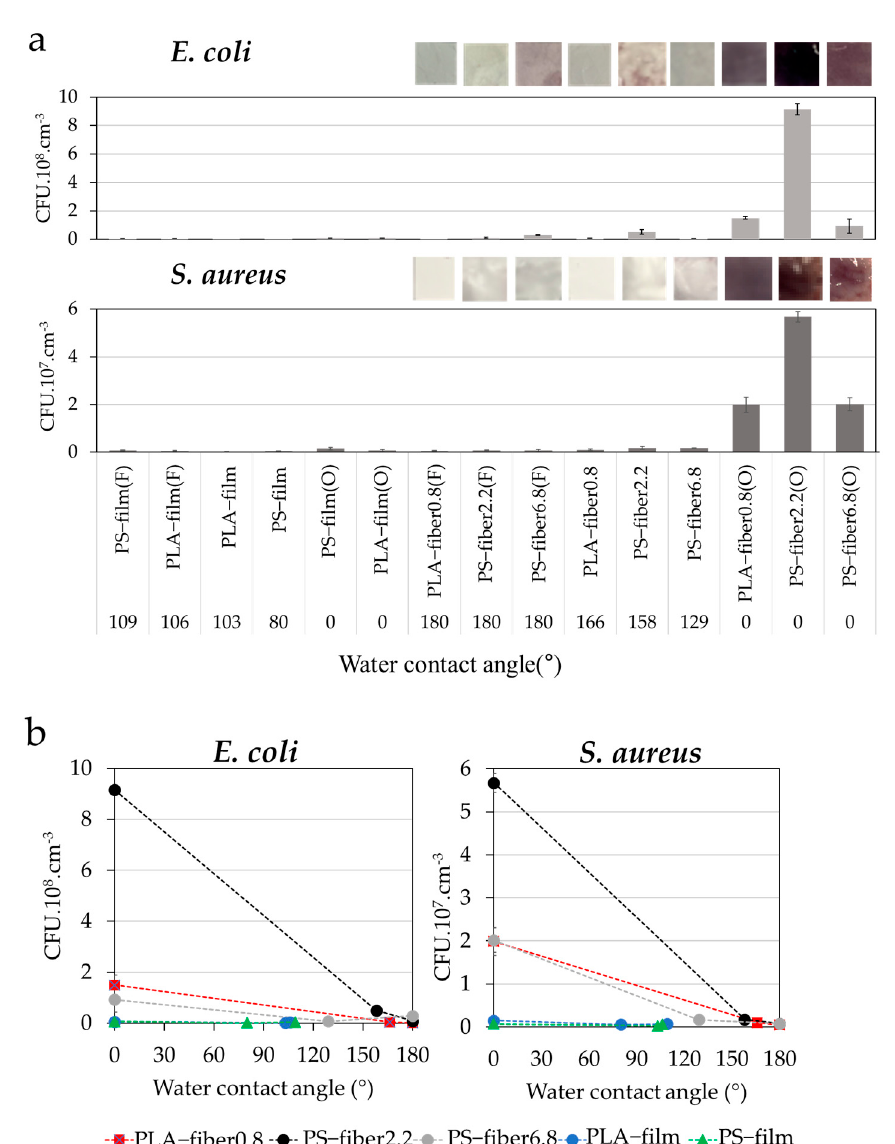
Figure 2. Bacterial adhesion rate under varied substrates. ( a ) Iodonitrotetrazolium chloride (INT) staining of E. coli and S. aureus adhesion on substrates with varied wetting properties; ( b ) E. coli and S. aureus adhesion as a function of surface contact angle.